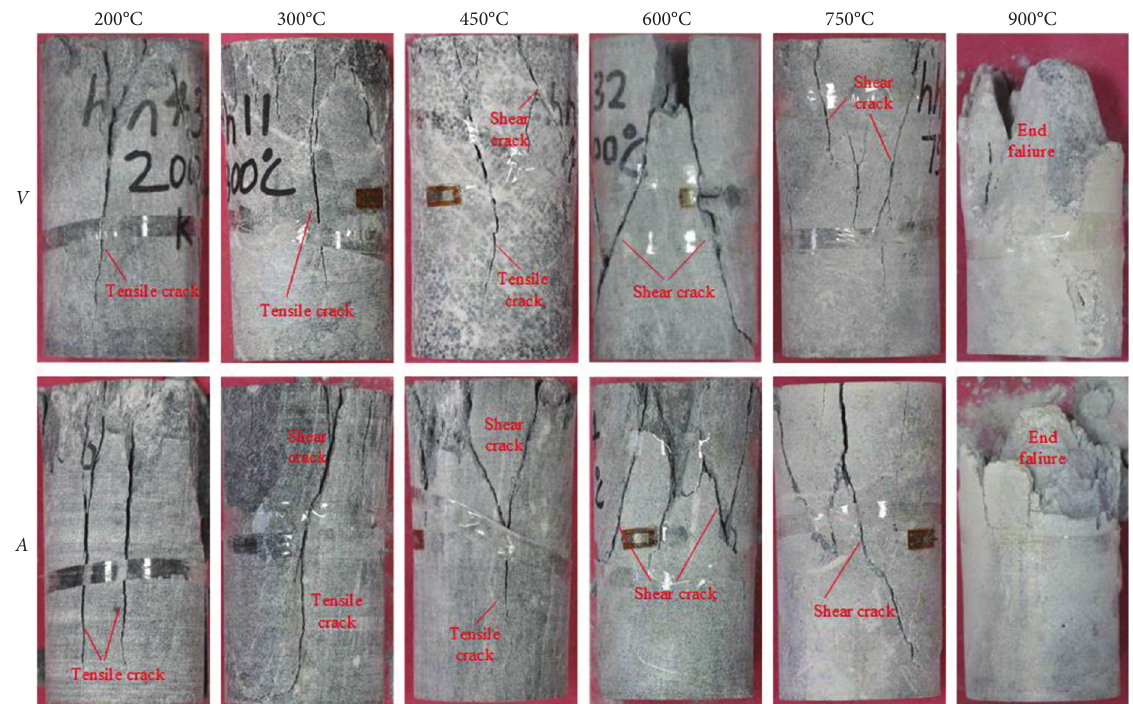
Figure 8: Ultimate failure modes of limestone specimens under uniaxial